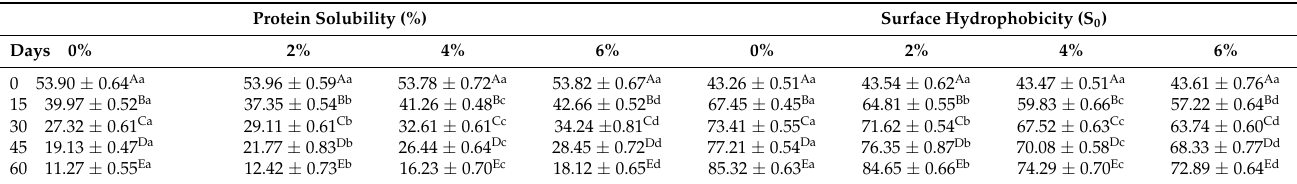
Table 1. Protein solubility and surface hydrophobicity of myofibrillar proteins treated with different concentrations of OVA-KC during 60 days of frozen storage at − 18 ◦